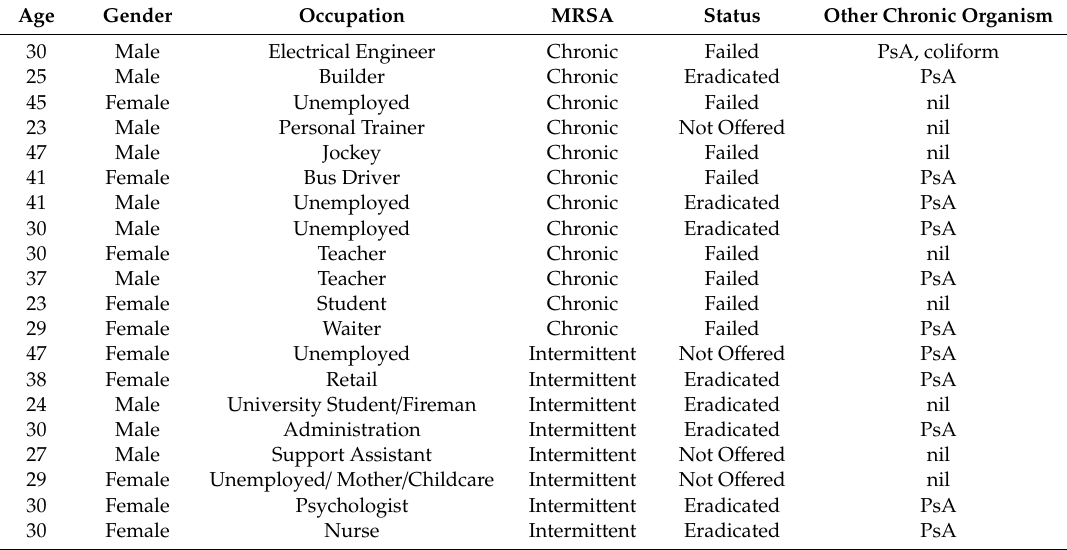
Table 2. Demographics of cystic fibrosis (CF) patients with chronic or intermittent MRSA